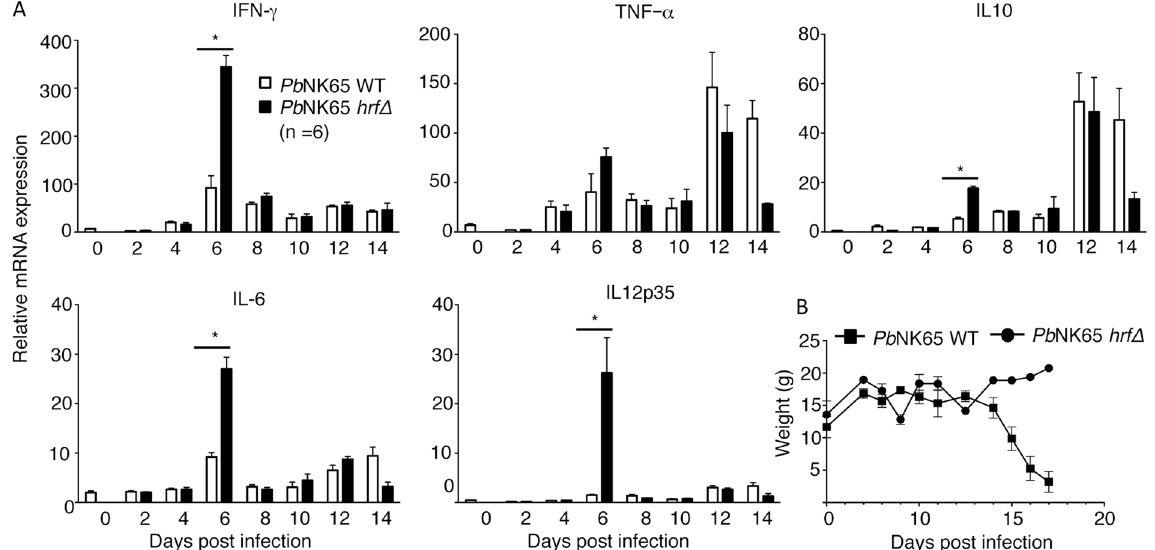
Figure 3. Immune response genes are differentially regulated by WT and hrf Δ parasites. ( A ) mRNA levels (RT- qPCR) normalized to HPRT of cytokine production in spleen cells measured at different time points p.i., every other day from day 2 to day 14 p.i., from mice infected with 10 5 WT or Pb NK65 hrf Δ iRBCs. ( B ) Determination of body weight measured over time during C57BL/6 mice infection. Error bars, SEM. Data are representative of two independent experiments with 5 mice per group. ( * p < 0.03; Mann Whitney test).